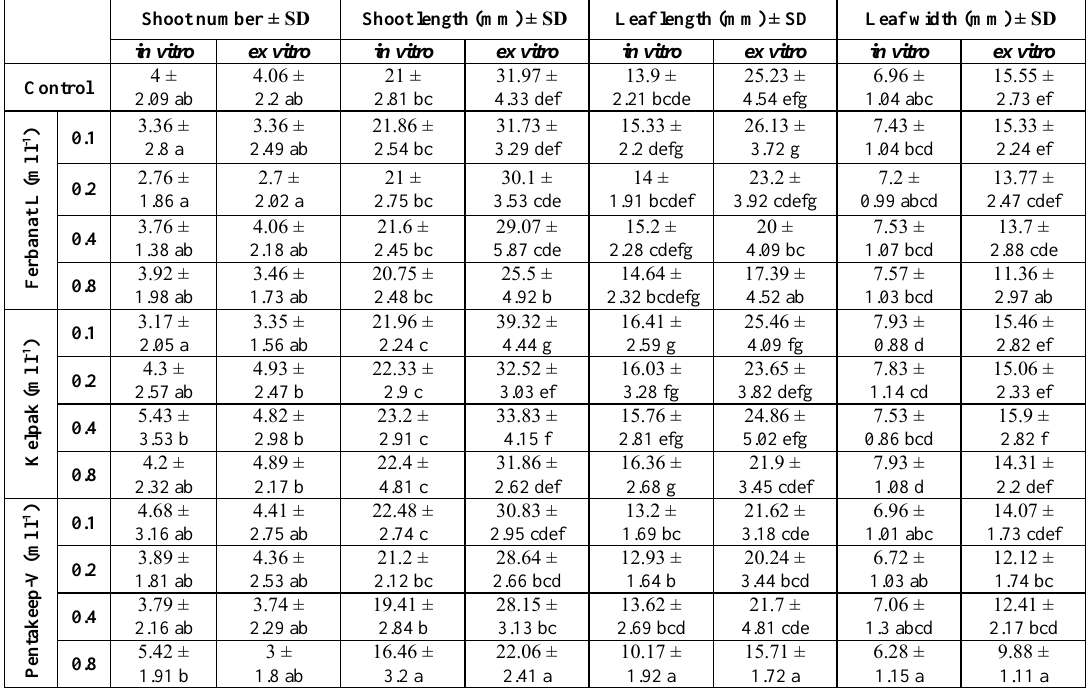
Table 2. Shoot and leaf parameters of in vitro and ex vitro Hosta ‘Gold Drop’ plants. Data represented by mean ± standard deviation (SD). Means with different letter are significantly different according to Tukey’s and Games-Howell’s comparison test at